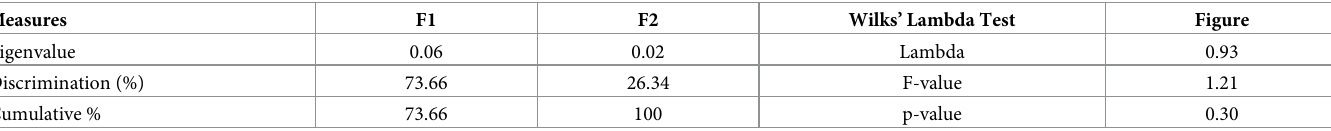
Table 5. Discriminant functions of institutional trust and Wilks’ lambda test. Measures